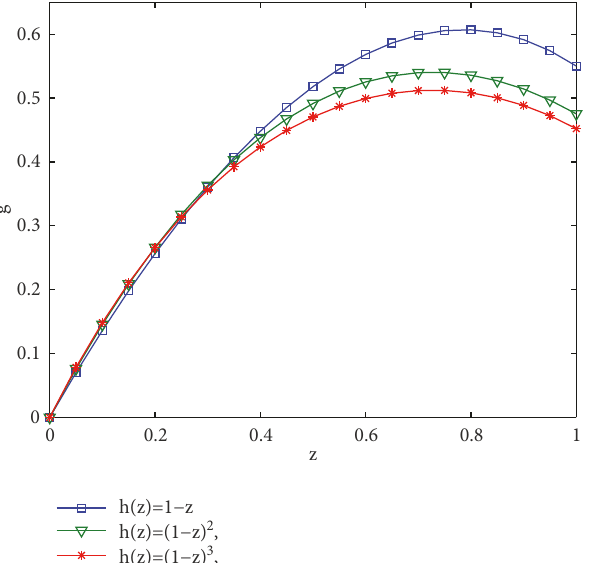
Figure 7: Thecomparisonof theresults ofapproximatesolution and numerical solution for 𝛼 = 0.5 , 𝑛 = 5.0 , 𝑘(𝑧) = 𝑧 , ℎ(𝑧) = 1 − 𝑧 .